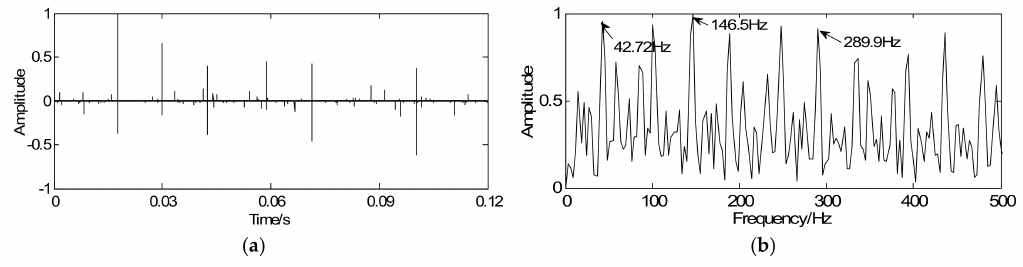
Figure 10. Detection results of inner-race fault using the proposed method: ( a ) waveform of sparse signal and ( b ) envelope spectrum of the sparse signal.